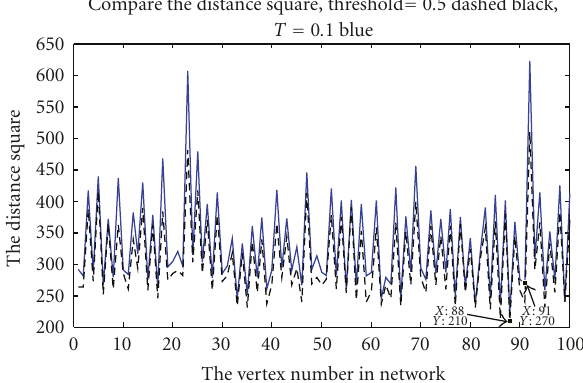
Figure 21: Inertia (distance squared) of the sensor networks with threshold 0.1 (solid blue line, positive curvature) and threshold 0.5 (dashed black line, negative curvature) versus vertex index. Observe that the inertia of the negatively curved network (dashed black) is lower than that of the positively curved network (solid blue).